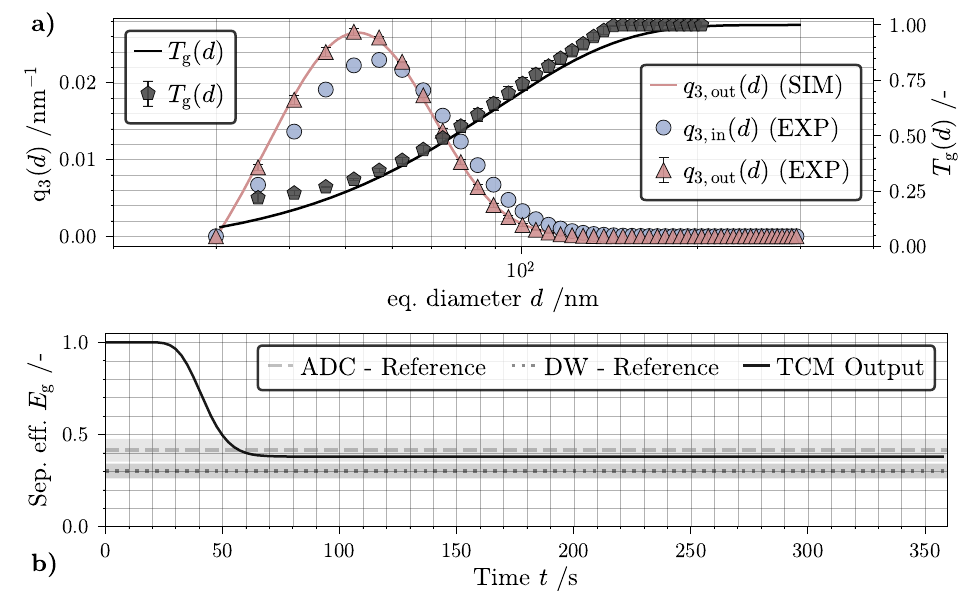
Figure 7. ( a ) Volume weighted density distribution of feed and centrate suspension (left ordinate) and global grade efficiency (right ordinate) at t N = 360 s . Markers indicate experimental data acquired by analytical disk centrifuge (ADC) measurements, solid lines mark the tubular centrifuge model (TCM) case output. ( b ) Global separation efficiency versus time calculated by the TCM model. Experimentally acquired reference with two independent methods drawn with horizontal dashed and dotted lines, gray areas highlight the standard deviation of both